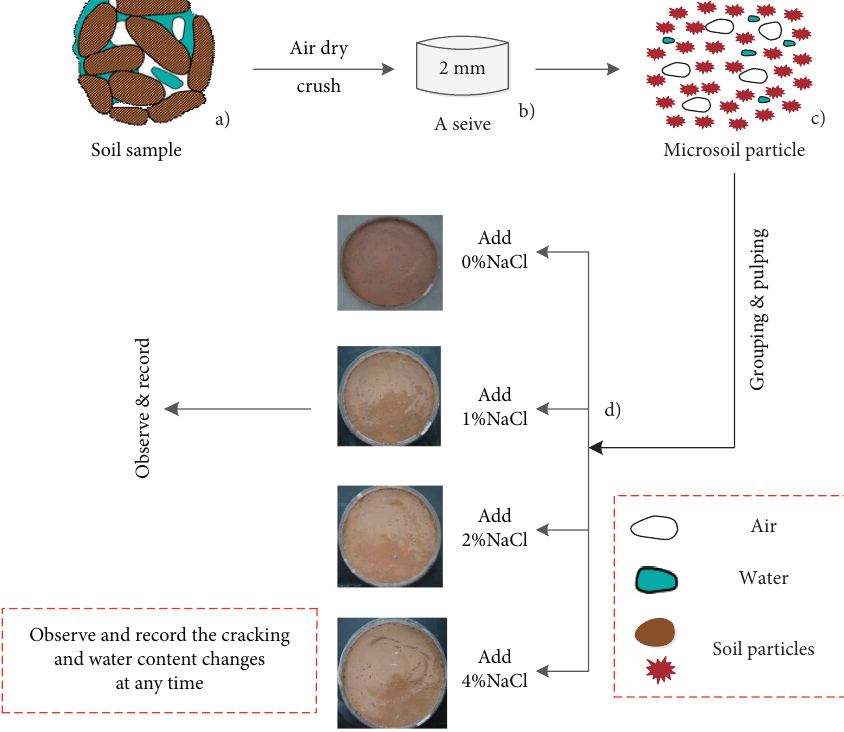
Figure 2: Flowchart of the experimental process. Table 1: Physical and mechanical properties of the soil from the Wang-Jing tower. Density